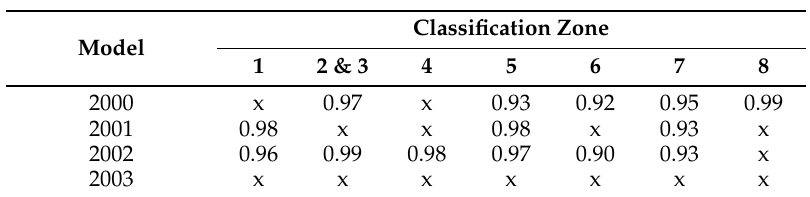
Table 5. OAs of modeled CI accounting for the number of harvests per year based on RF models (the situation that multi-annual RF outperformed annual RF models are grey-shaded); and all validation samples of all available years with the multi-annual RF model. ‘x’ = no reference Landsat data available within this classification zone and